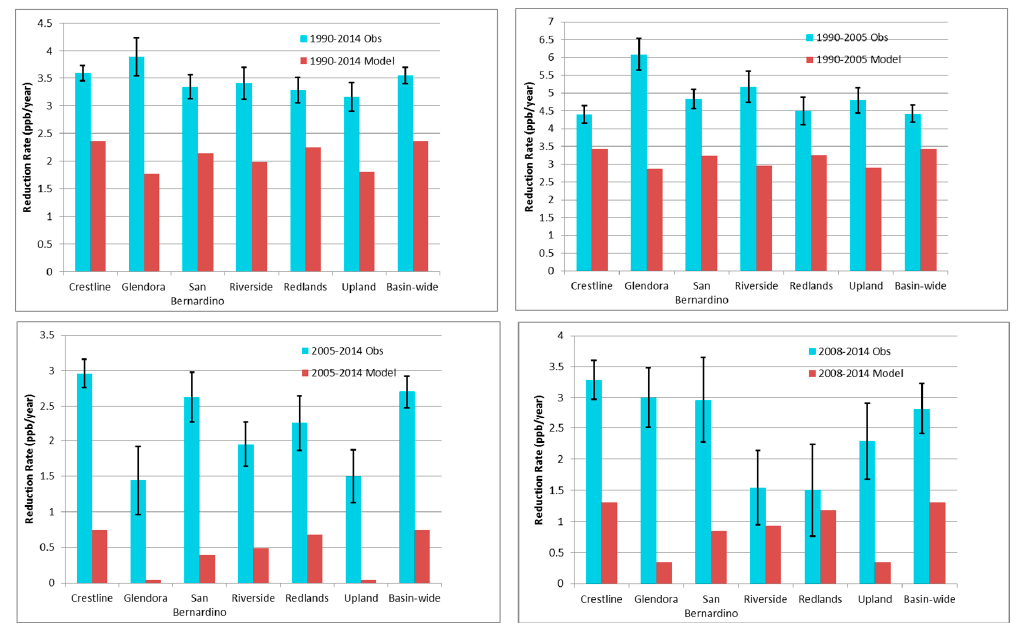
Figure 5. Multi-year modeled and observed reduction rates of 3-year ozone design values at selected monitors using the 2012 AQMP modeling database for the periods from 1990 to 2014 ( top left ), 1990 to 2005 ( top right ), 2005 to 2014 ( bottom left ), and 2008 to 2014 ( bottom right ). The observed rates include error bars to indicate the uncertainty in their calculation.